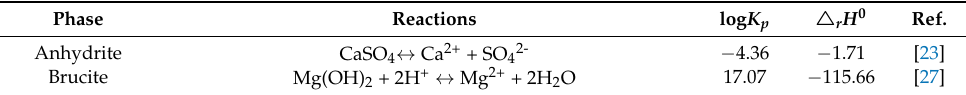
Table A1. Thermodynamic properties of the phases at 25 ◦ C used in the simulation.